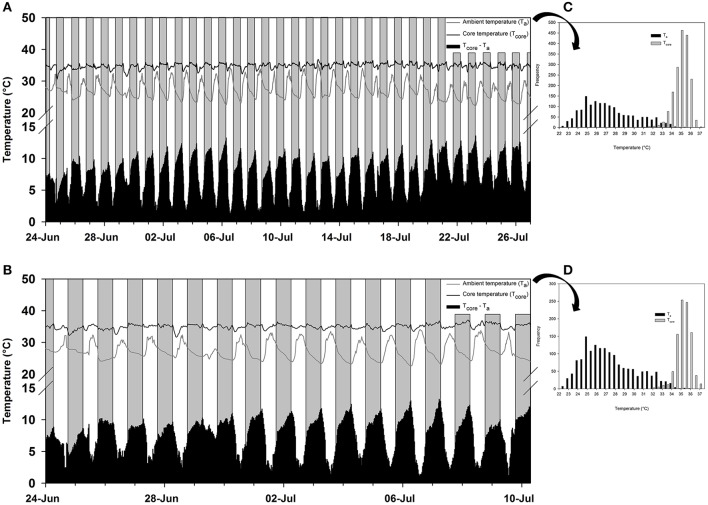
The free-ranging temperature profile in western tarsiers (Cephalopachus bancanus). (A) The ambient temperatures (Ta; gray line) and core temperatures (Tcore; black line) recorded in a female from 00:00 24th June 2015 to 00:00 27th July 2015. (B) The ambient temperatures (Ta; gray line) and core temperatures (Tcore; black line) recorded in a male from 00:00 24th June 2015 to 06:30 10th July 2015. The grey and white bars represent night and day, respectively, and the black bars at the base of each plot represent the temperature differential between the Ta and Tcore. (C,D) The frequency distribution of the respective Tas and Tcores observed in the female and male tarsier's temperature profile.